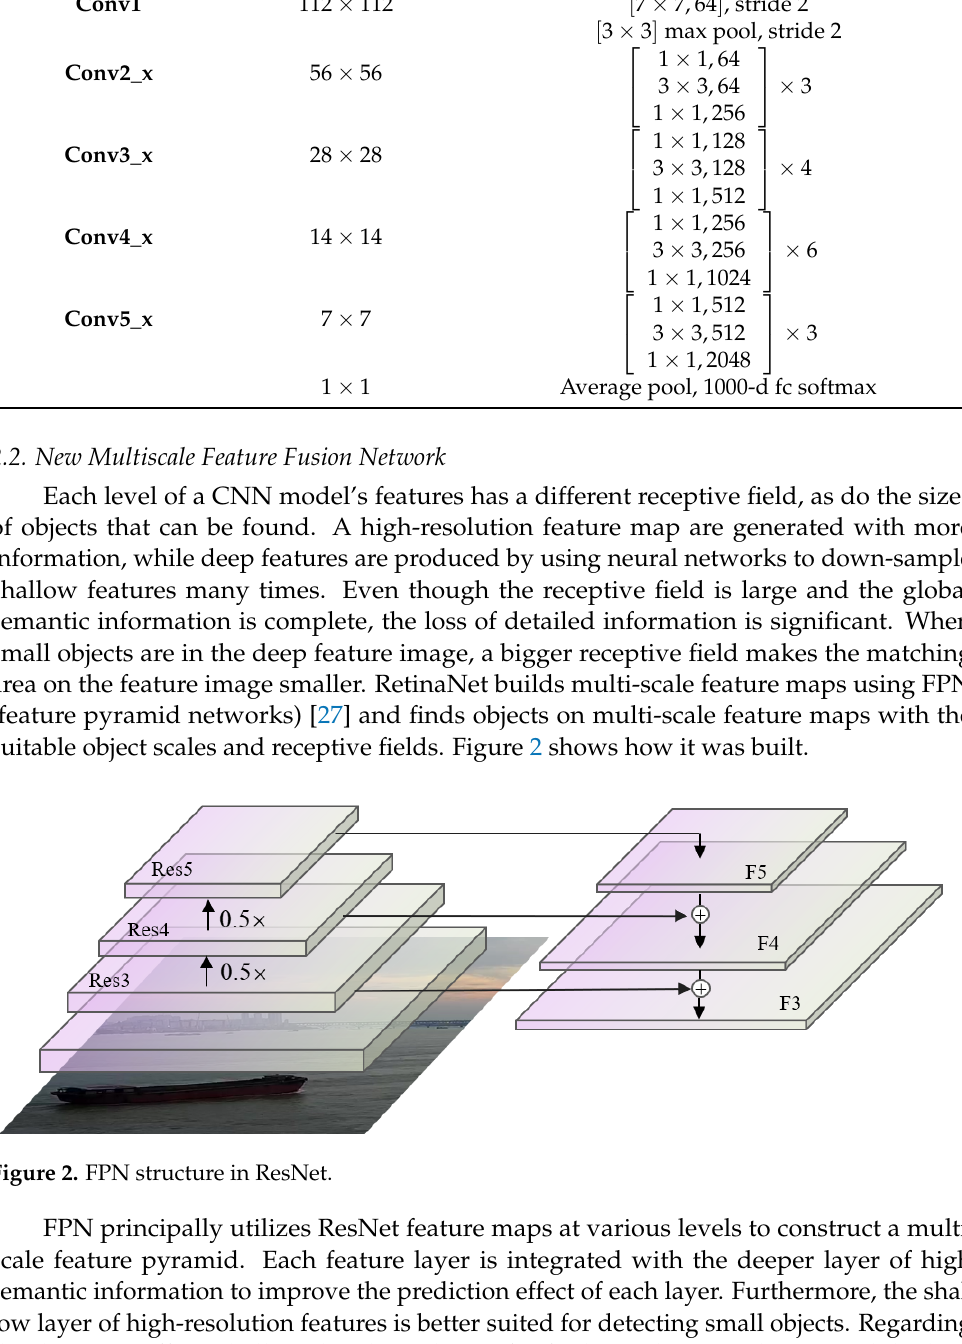
Table 1. Feature extraction network (ResNet50) parameter.